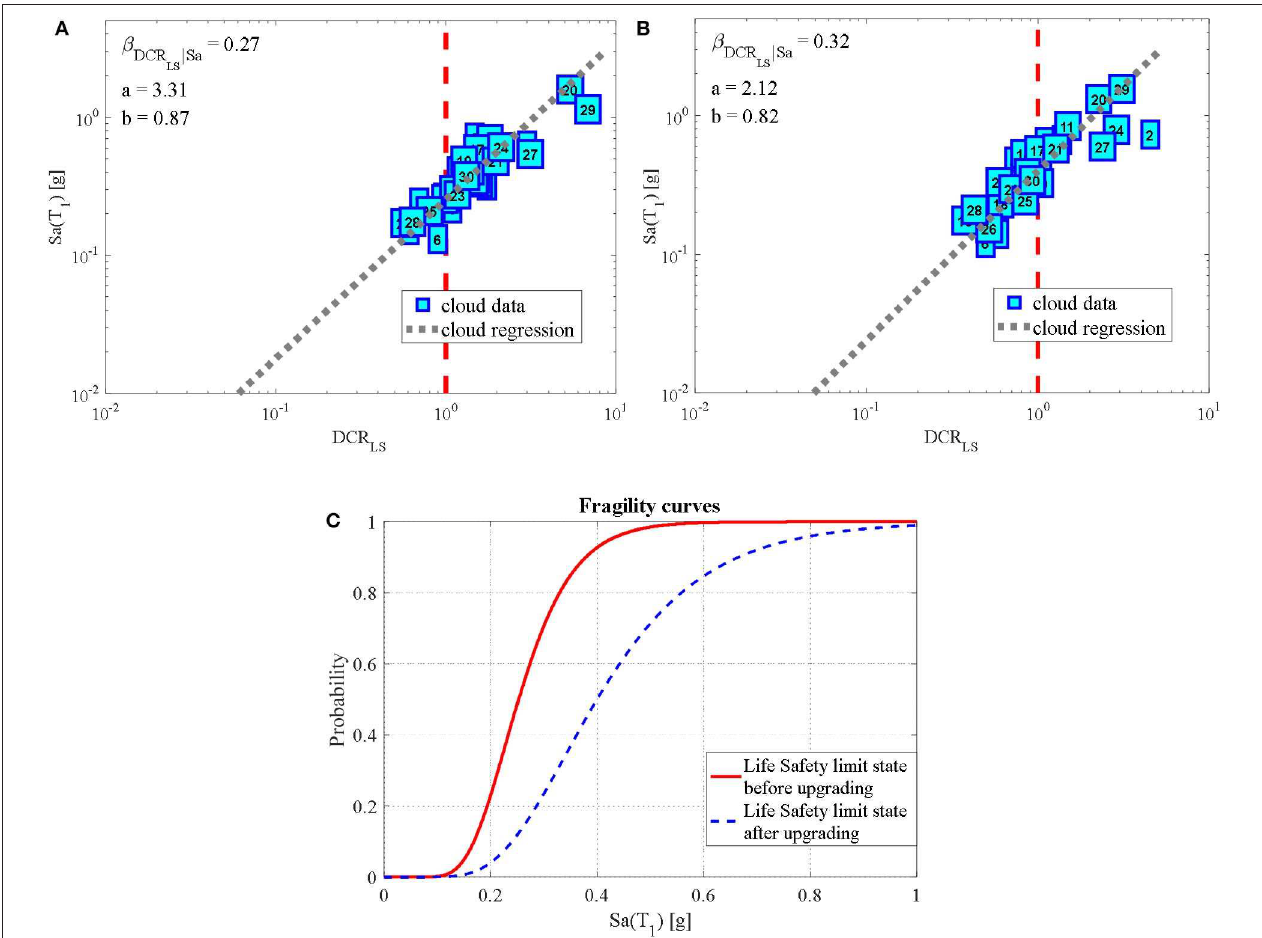
FIGURE 6 | Cloud regression for life safety (LS) (A) before upgrading and (B) after upgrading. (C) Fragility curves before and after